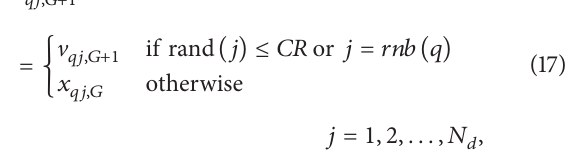
Figure 3: Decoding